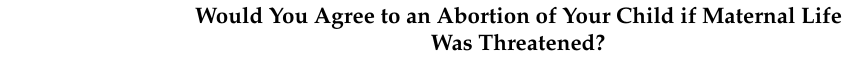
Table 7. Approval of pregnancy termination in case of a threat to maternal life vs. opinion on the possibility of abortion of one’s own child if maternal life was